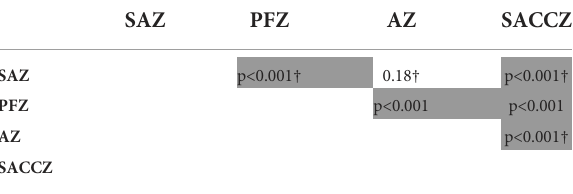
TABLE 1 Inter-zonal variability: p-values from the t-tests conducted majority of the cruises being similar, except S53 (Table 2C), on the F v /F m for all cruises combined and compared per zone. which showed a higher mean F v /F m (0.25±0.04, p<0.001) SAZ PFZ AZ SACCZ compared to all other cruises (0.21 - 0.22) (Supplementary Table S5). The SAZ was alsocharacterized by relativelyhigh inter-annual SAZ p<0.001 † 0.18 † p<0.001 † variability in F v /F m , most notably during S49 which was typically PFZ p<0.001 p<0.001 higher than all other years, except S54 (Table 2A). AZ p<0.001 † SACCZ